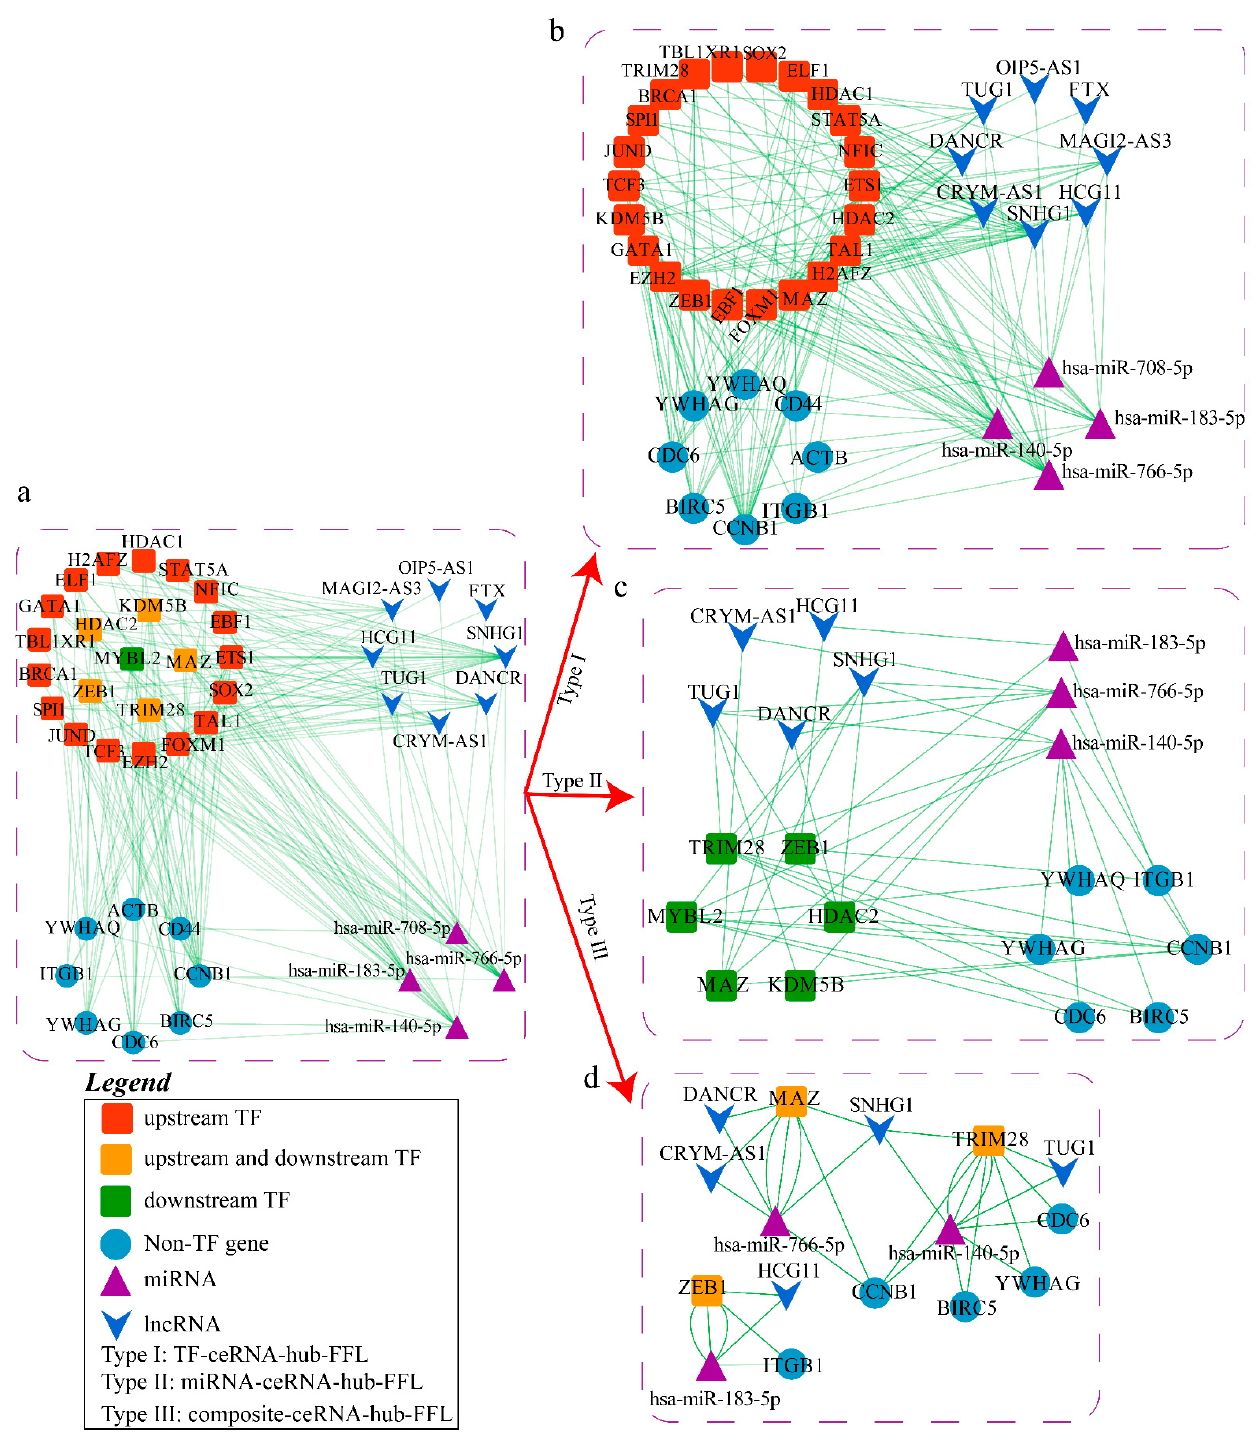
Figure 11. CeRNA-hub-FFL network: ( a ) The total network can be divided into three different types of ceRNA-hub-FFL networks; ( b ) Type I subnetwork; ( c )Type II subnetwork; ( d ) Type III subnet- work.